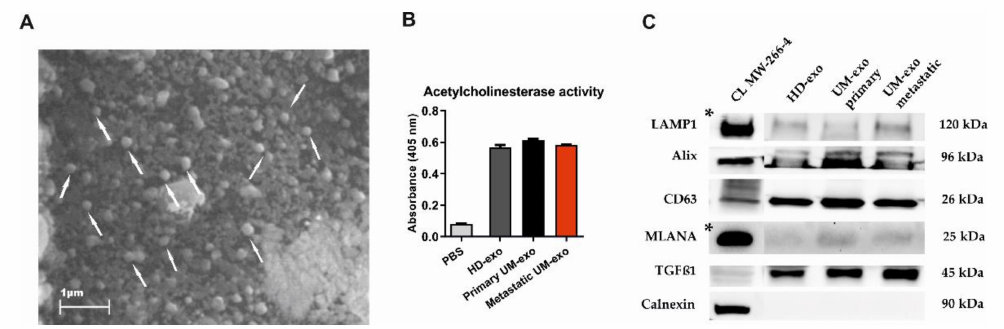
Figure 1. The characteristics of exosomes isolated from the serum of uveal melanoma patients with primary and metastatic disease (UM-exo primary and UM-exo metastatic) and healthy donors (HD- exo). The scanning electron microscopy (SEM) showed the proper shape and size (exosomes marked with white arrows) ( A ). The isolated exosomes indicate high levels of acetylcholinesterase activity. Data represent the mean ± SD from three technical replicates of absorbance readout at 405 nm from the pooled serum ( B ). The expression of proteins characteristic for small extracellular vesicles— endosomal origin (LAMP1, Alix, CD63), their protein cargo (TGF β 1), the tumour-origin (MLANA), and absence of organelle-specific proteins (Calnexin) was confirmed by Western blot. The band marked with * were obtained from the short-time exposure of the same membrane, due to differences in the protein expression level between the cell line lysate and exosomes ( C ). The uncropped Western Blot images can be found in Figure